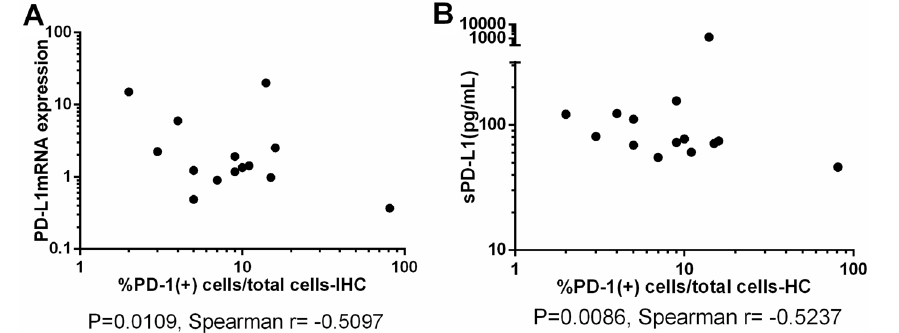
Figure 4. ( A ) Correlation between PD-1 level in tumor tissues and PD-L1mRNA level in PBMC. ( B ) Correlation between PD-1 level in tumor tissues and sPD-L1